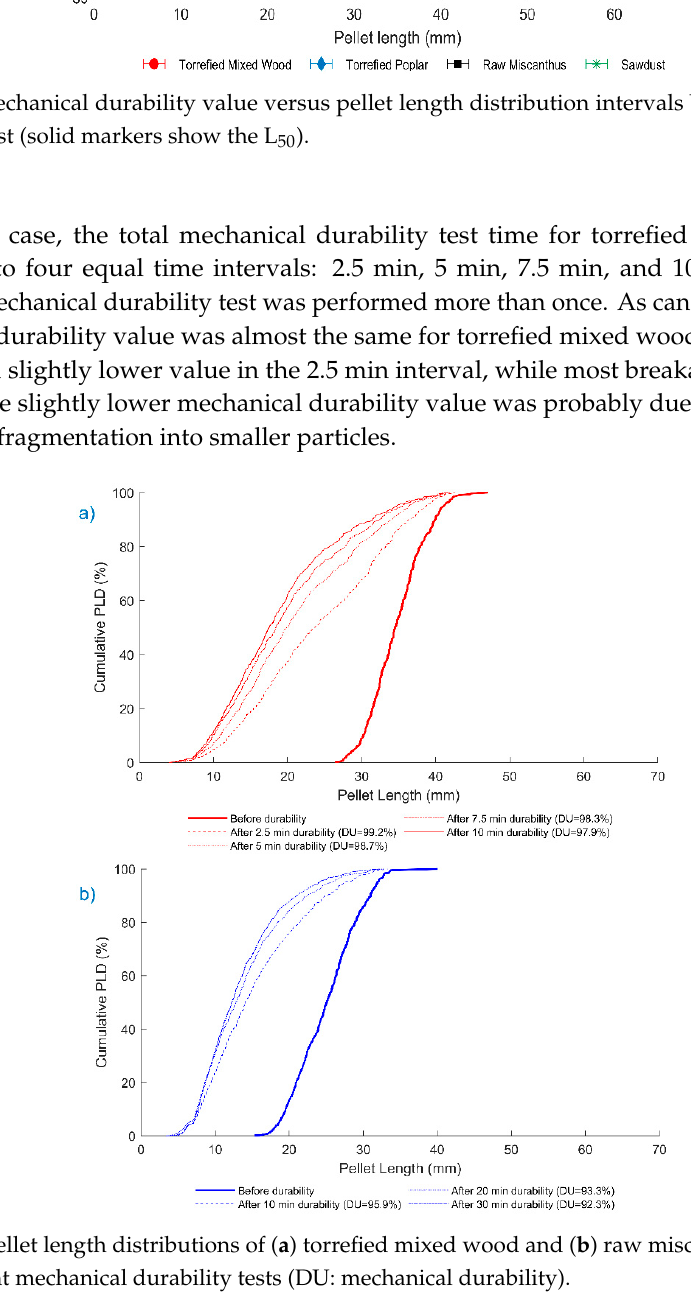
Figure 9. Mechanical durability value versus pellet length distribution intervals before mechanical durability test (solid markers show the L 50 ).